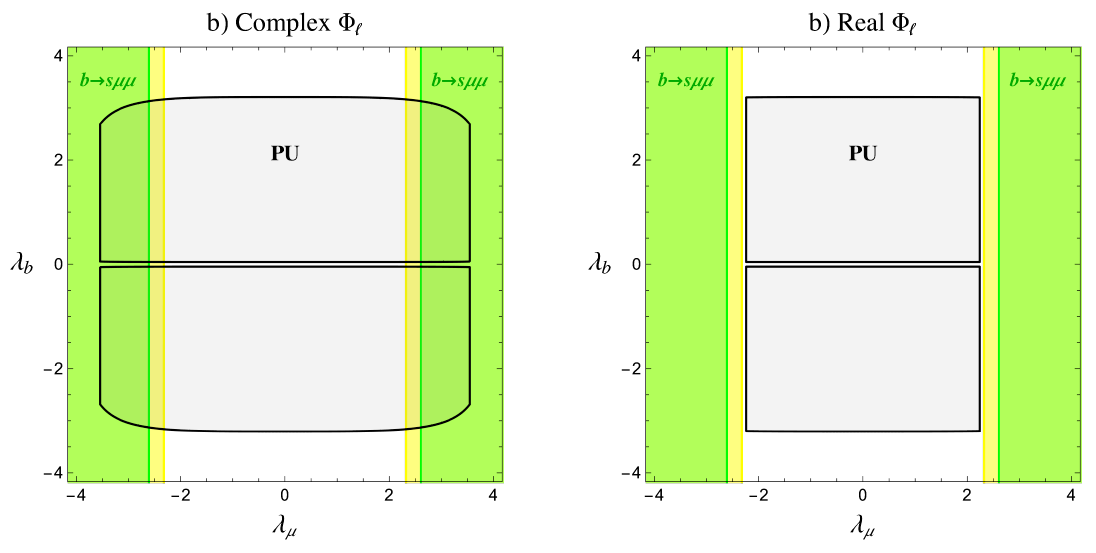
Figure 5 . In gray we show the regions of the parameter space compatible with PU. In green and yellow we show the regions compatible with the R ∆ C µ = − ∆ C µ and assuming a common NP mass m 9 10